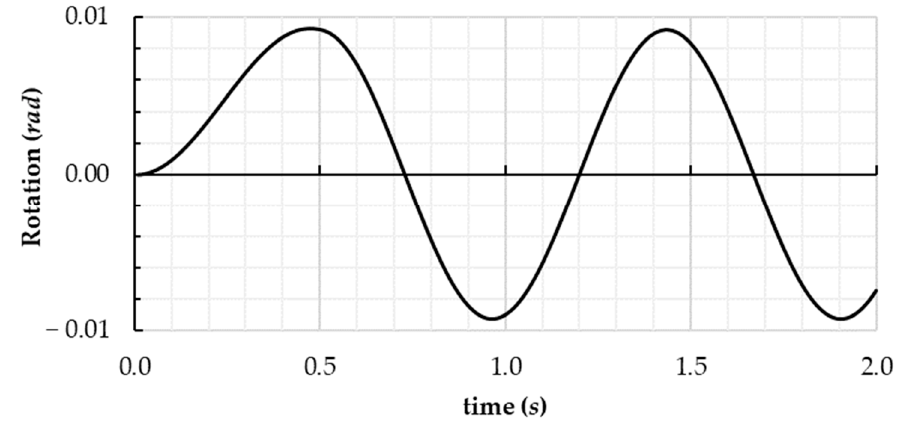
Figure 7. Rotation about y -axis, θ y .